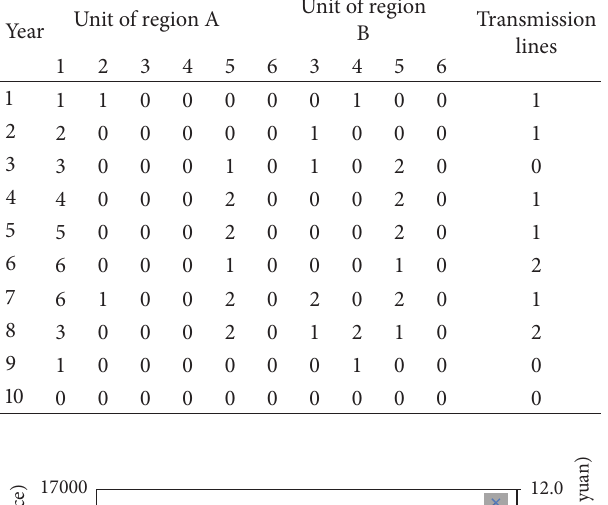
Table 12: Interregional power planning optimization results with REQ.